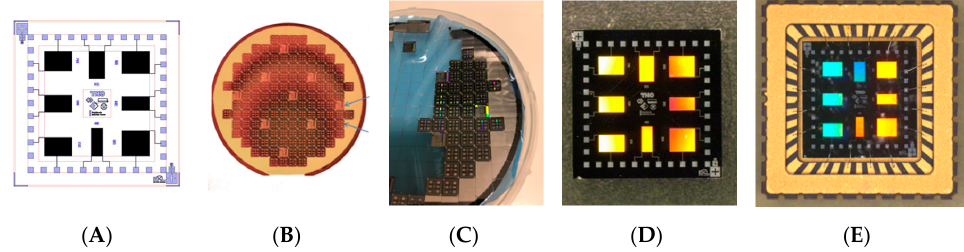
Figure 1. Steps in the production process of the sensor chips: ( A ) Design of the chip layout; ( B ) manufacturing of the wafer; ( C ) dicing of the wafer into individual dies; ( D ) individual die having eight interdigitated electrodes; ( E ) packaged die (= sensing chip).